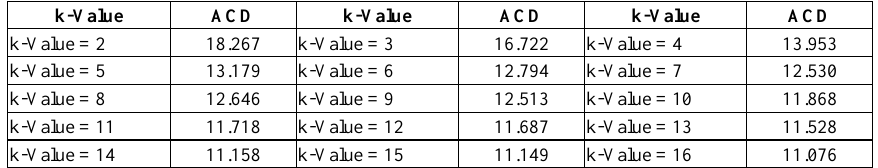
Table 7. Average within Centroid Distance